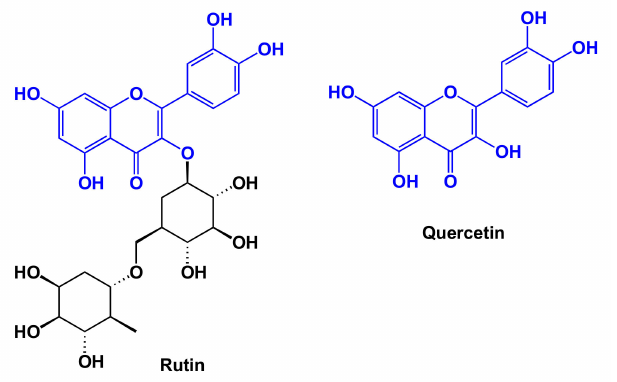
Figure 5. Chemical structure of rutin and